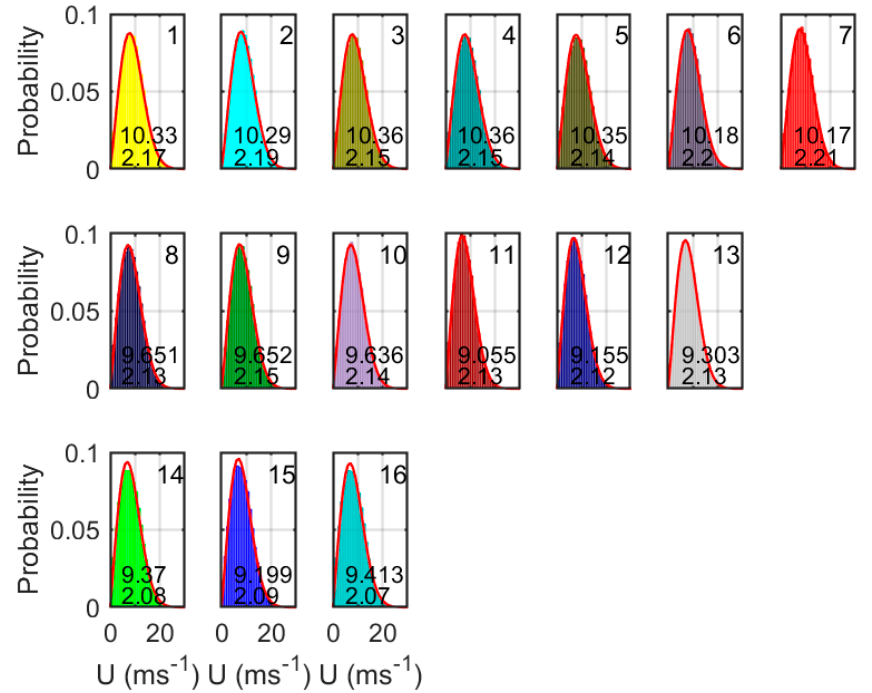
Figure 7. Histograms of the hourly wind speed data for each LA. The color coding is as in Figures 1 and 2. The north LA are shown in the top row, the mid LA in the central row and the south LA in the bottom row. The LA numbers are indicated in the top right of each panel. The numbers at the bottom of each panel are the Weibull scale parameter (above) and the Weibull shape parameter (below). The red line is the two parameter Weibull fit to the distributions.